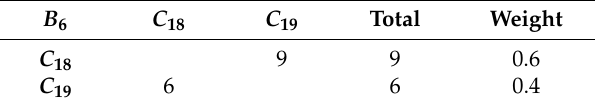
Table A7. Judgment matrix of C 18 – C 19